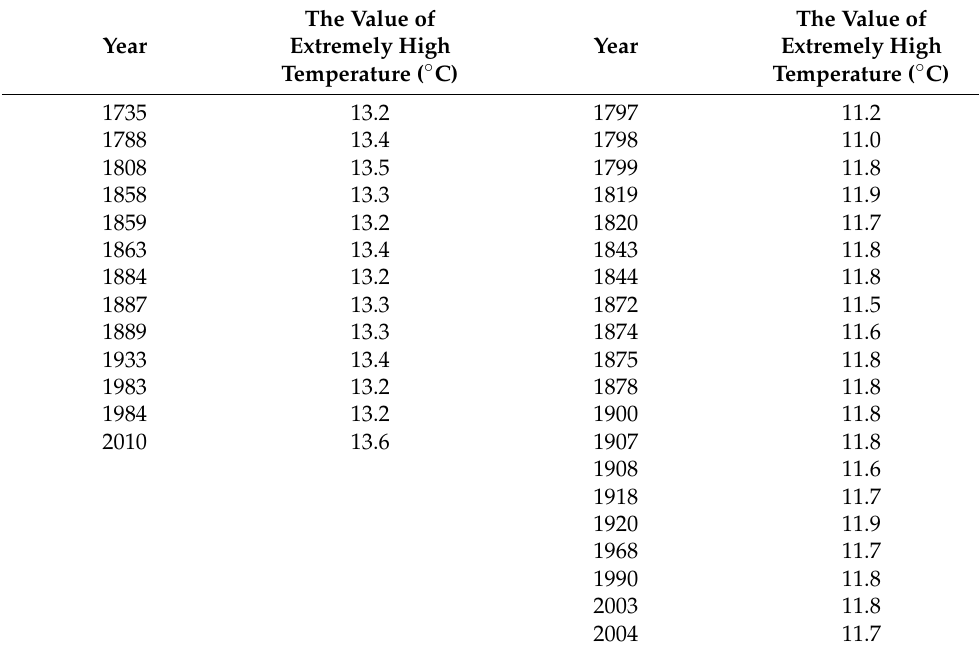
Table 3. Extreme events during the past 278 years.